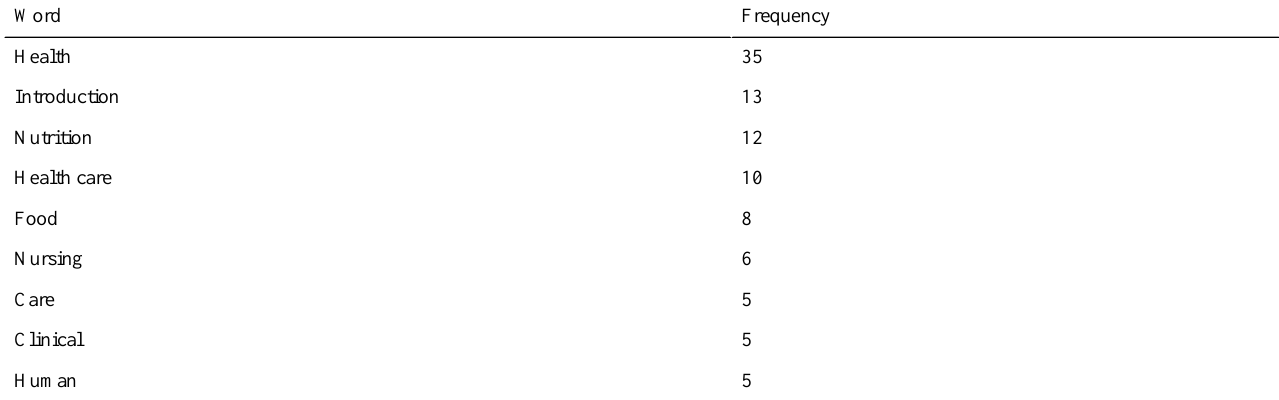
Table 9. Frequently used words in MOOC